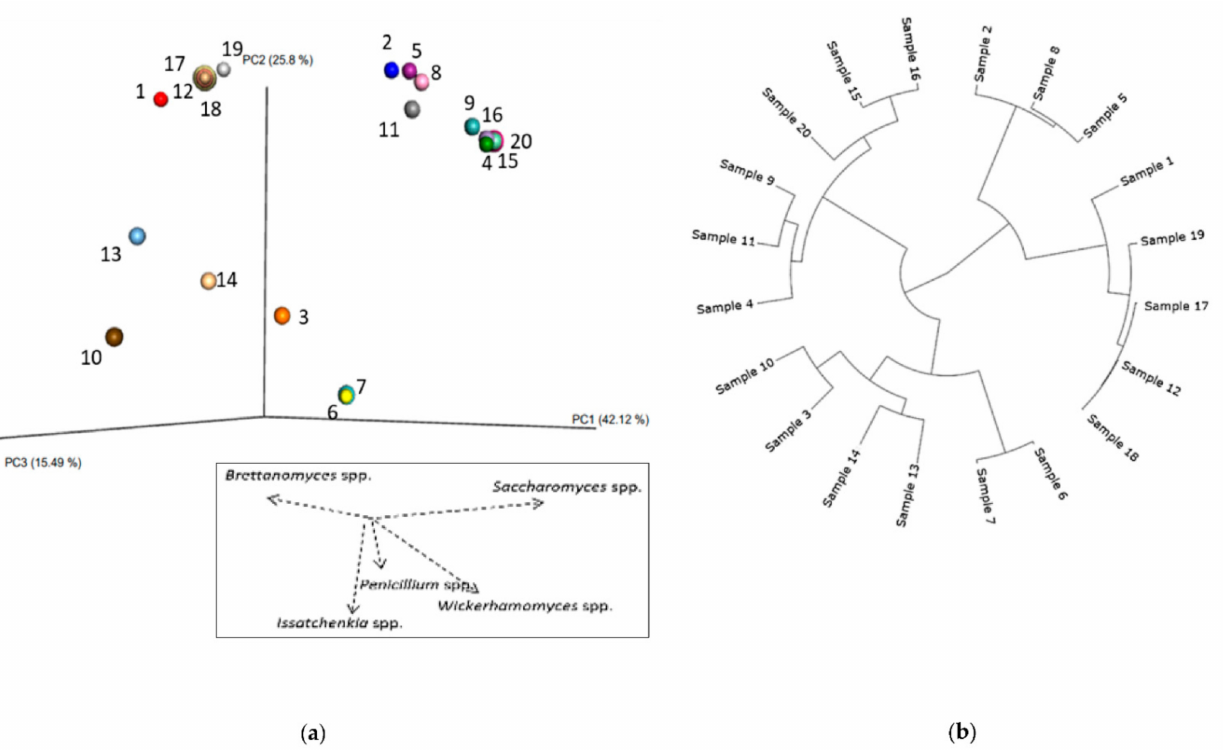
Figure 6. Sample similarity based on fungal composition. ( a ) PCoA tridimensional plot created using the matrix of pairwise distances between samples calculated by the Bray–Curtis dissimilarity using the genera found in the microbial composition. Below the PCoA plot is a schematic representation based on the sample composition, in which arrows demonstrate different directions for sample localization according to the presence and concentration of Brettanomyces spp., Saccharomyces spp., Penicillium spp., Issatchenkia spp., and Wickerhamomyces spp. ( b ) The tree shows clustering of the samples by similarity of their taxonomic composition, calculated by the Bray–Curtis dissimilarity at the ASV level using Ward’s